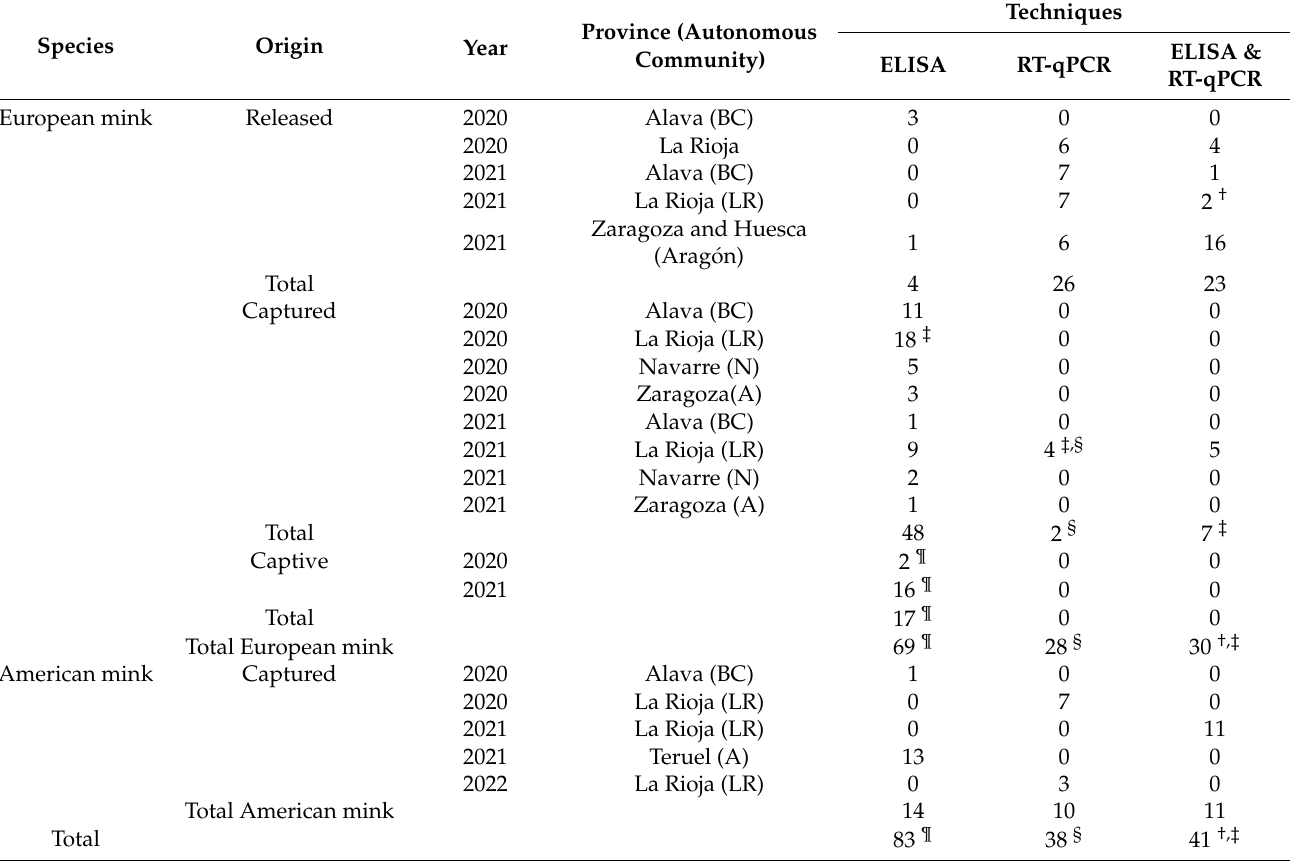
Table 1. Number of mink analysed in this study using different techniques for the SARS-CoV-2 antibody and nucleic acid